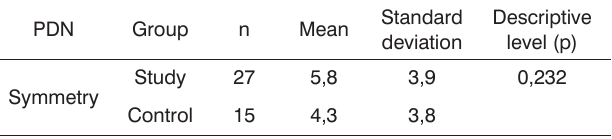
Left p≤0,05 Table 6. Comparing the optokinetic symmetry between the groups